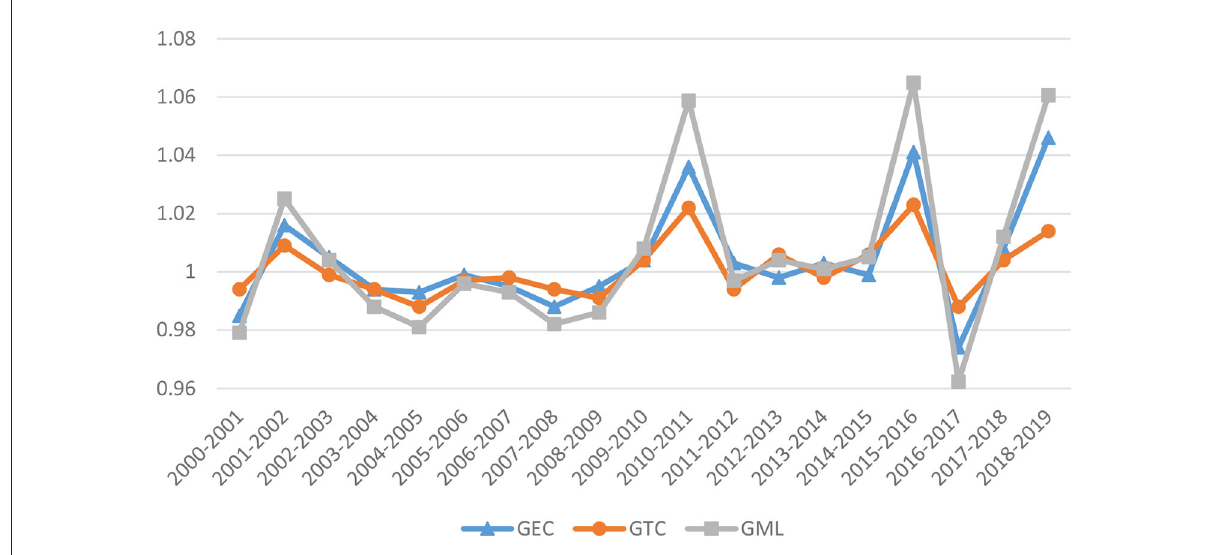
FIGURE4 Trends in the GML index and its decomposition in China’s pharmaceutical